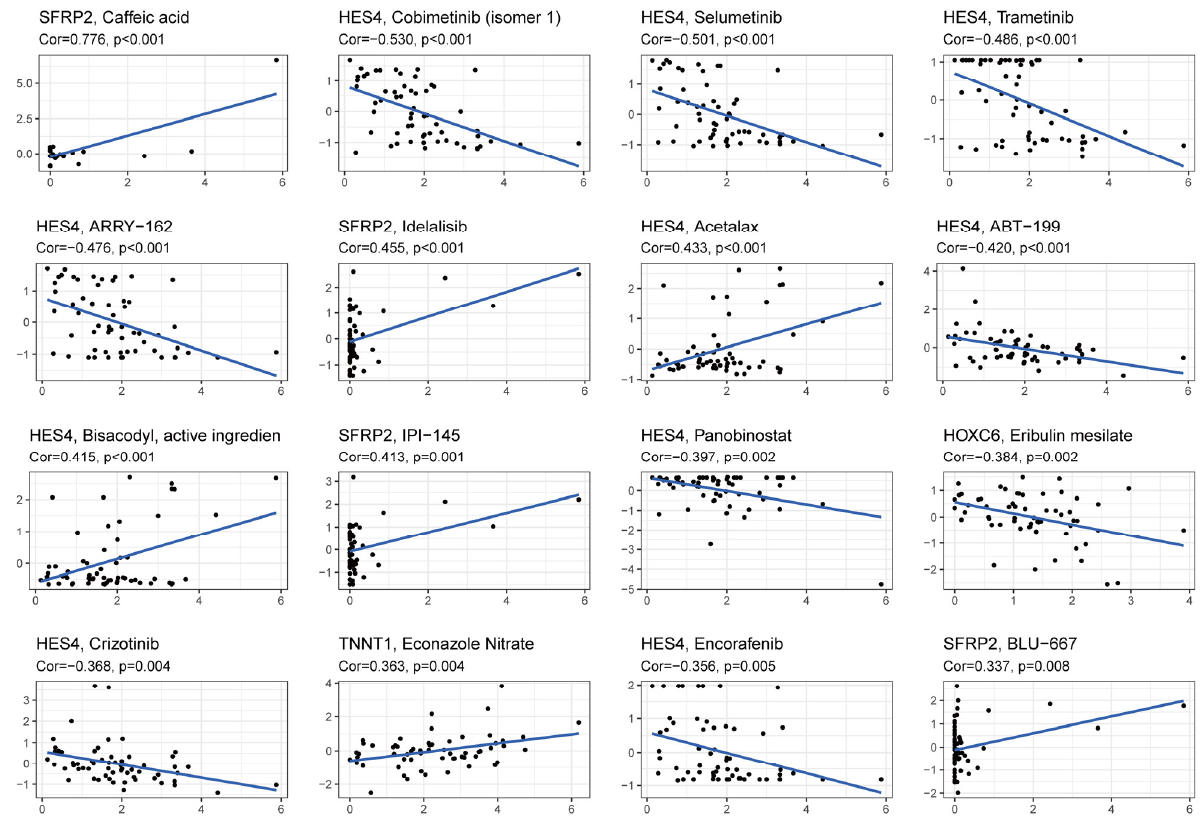
Figure 9. Correlation analysis of model genes and drug sensitivity.